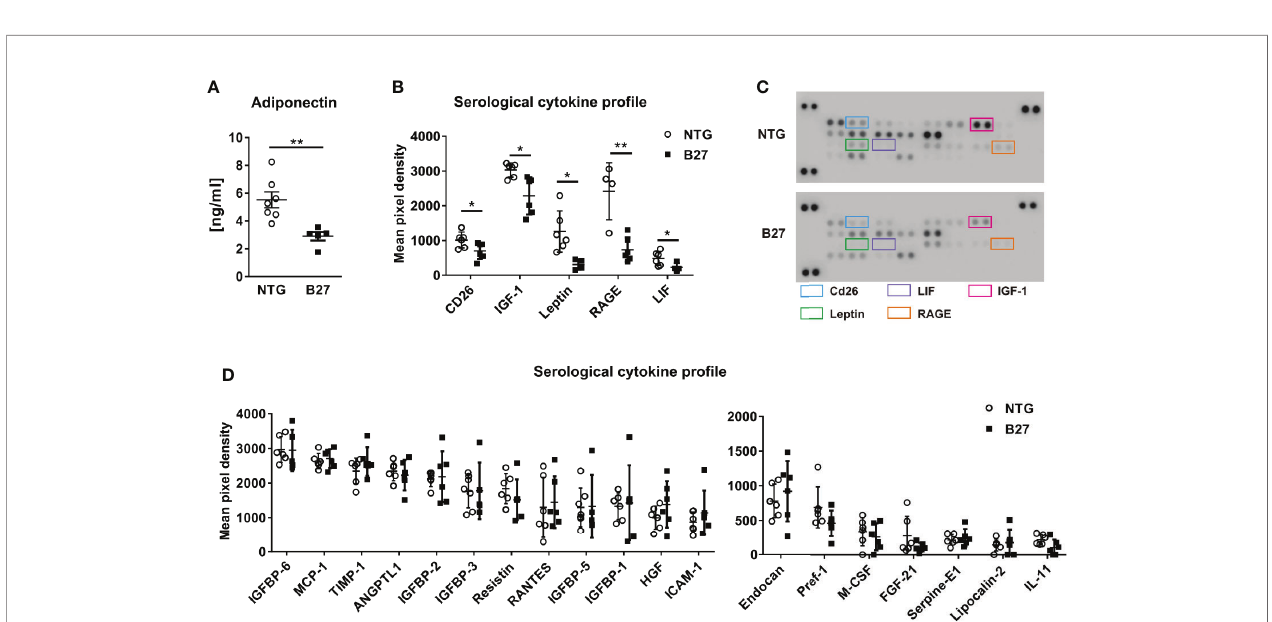
FIGURE 4 | Altered metabolic pro fi le in B27 transgenic rats. (A) Serum concentrations of adiponectin in NTG and B27 rats (n=5-7 per group). (B) Signi fi cantly regulated cytokines in the serum of NTG and B27 rats. (C) Representative image of cytokine pro fi ler array results from serum of NTG and B27 rats. Signi fi cant ones are highlighted. (D) Relative levels of not-regulated obesity-related cytokines in NTG and B27 rats (B,D n=6-8 per group). Data are presented as mean ± SD. *p ≤ 0.05 and **p ≤ 0.001 NTG vs. B27 via unpaired Student ’ s